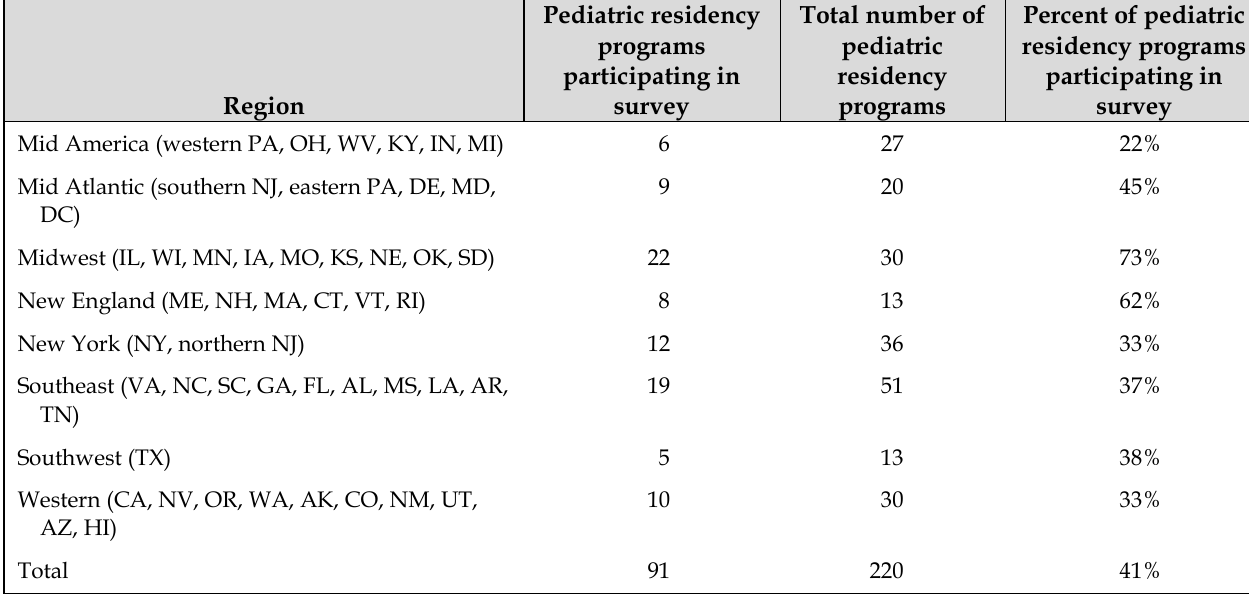
Table 1 Survey participation by region